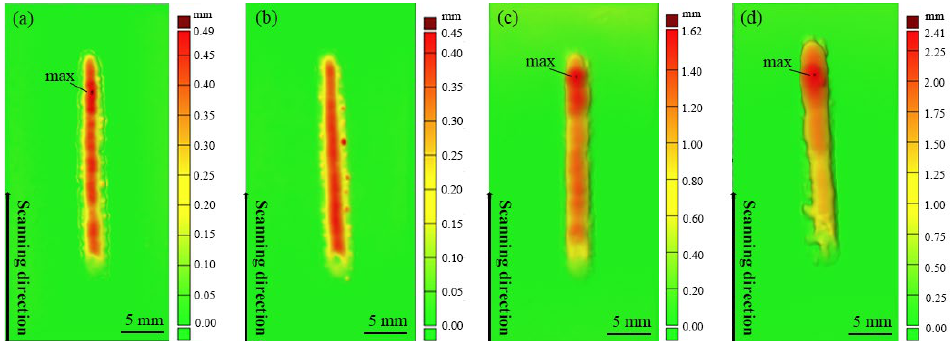
Figure 5. Three-dimensional laser-scanned morphology of the Stellite 6/WC cladding layer: ( a ) S1; ( b ) S2; ( c ) S3; ( d ) S4. ( b ) S2; ( c ) S3; ( d )